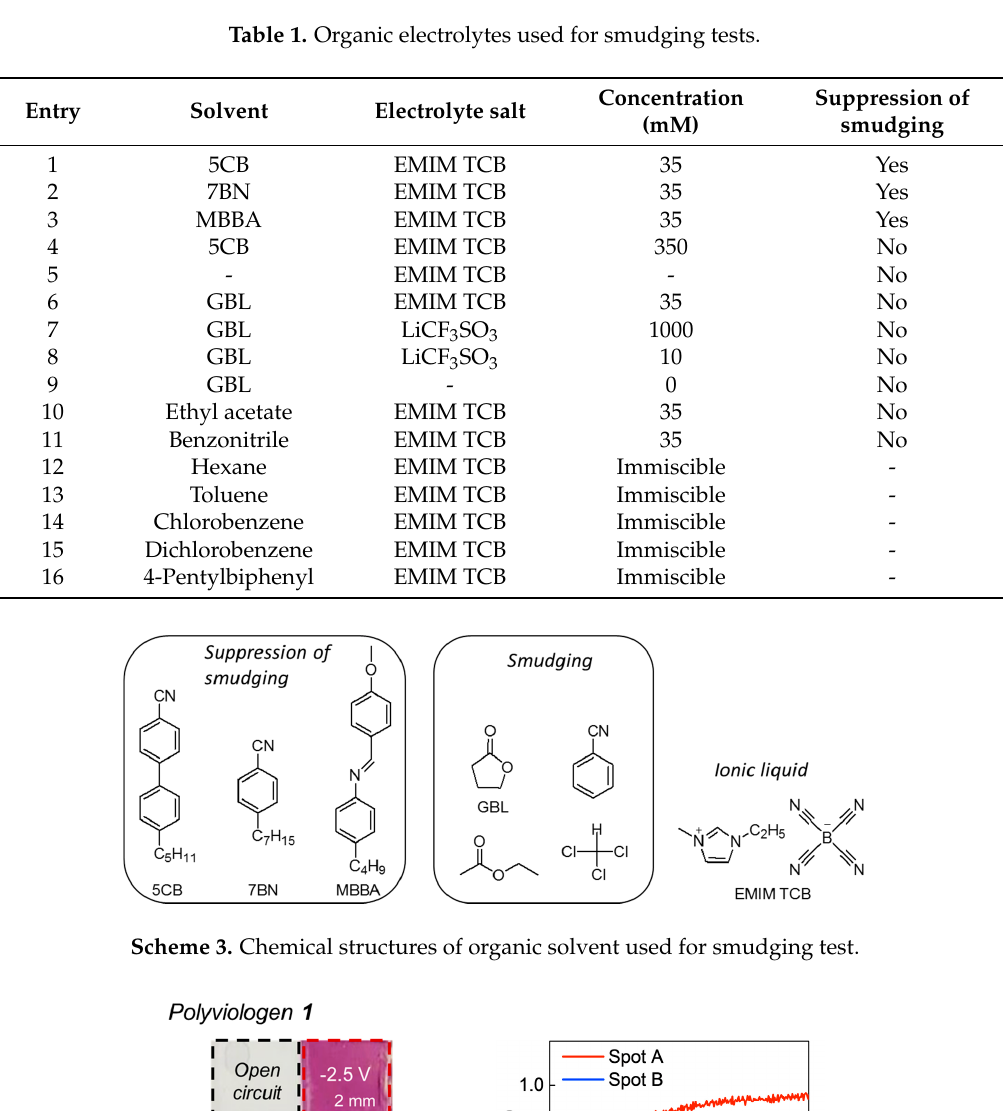
Table 1. Organic electrolytes used for smudging tests.